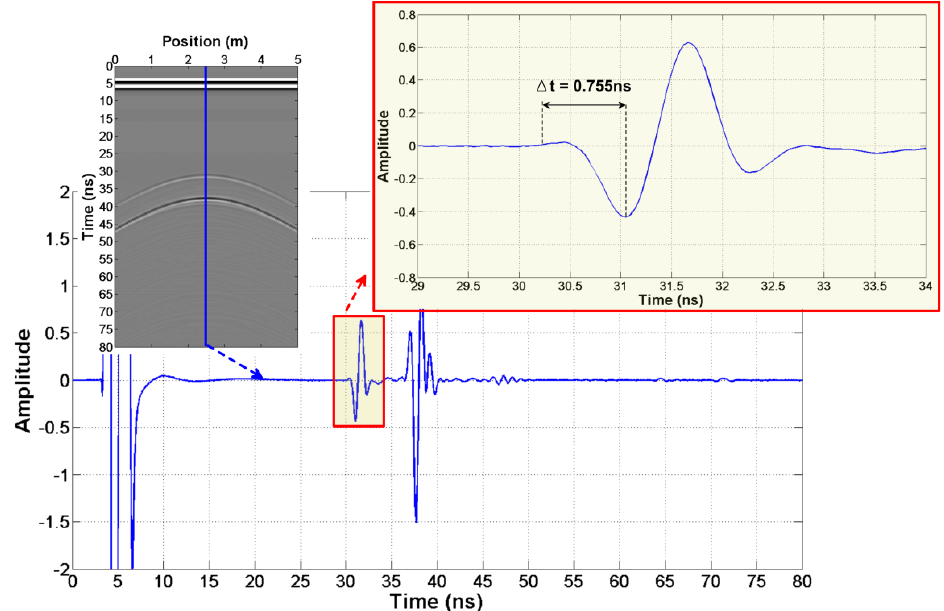
Figure 6. The reflection wavelet waveform of the abnormal body in the second case.